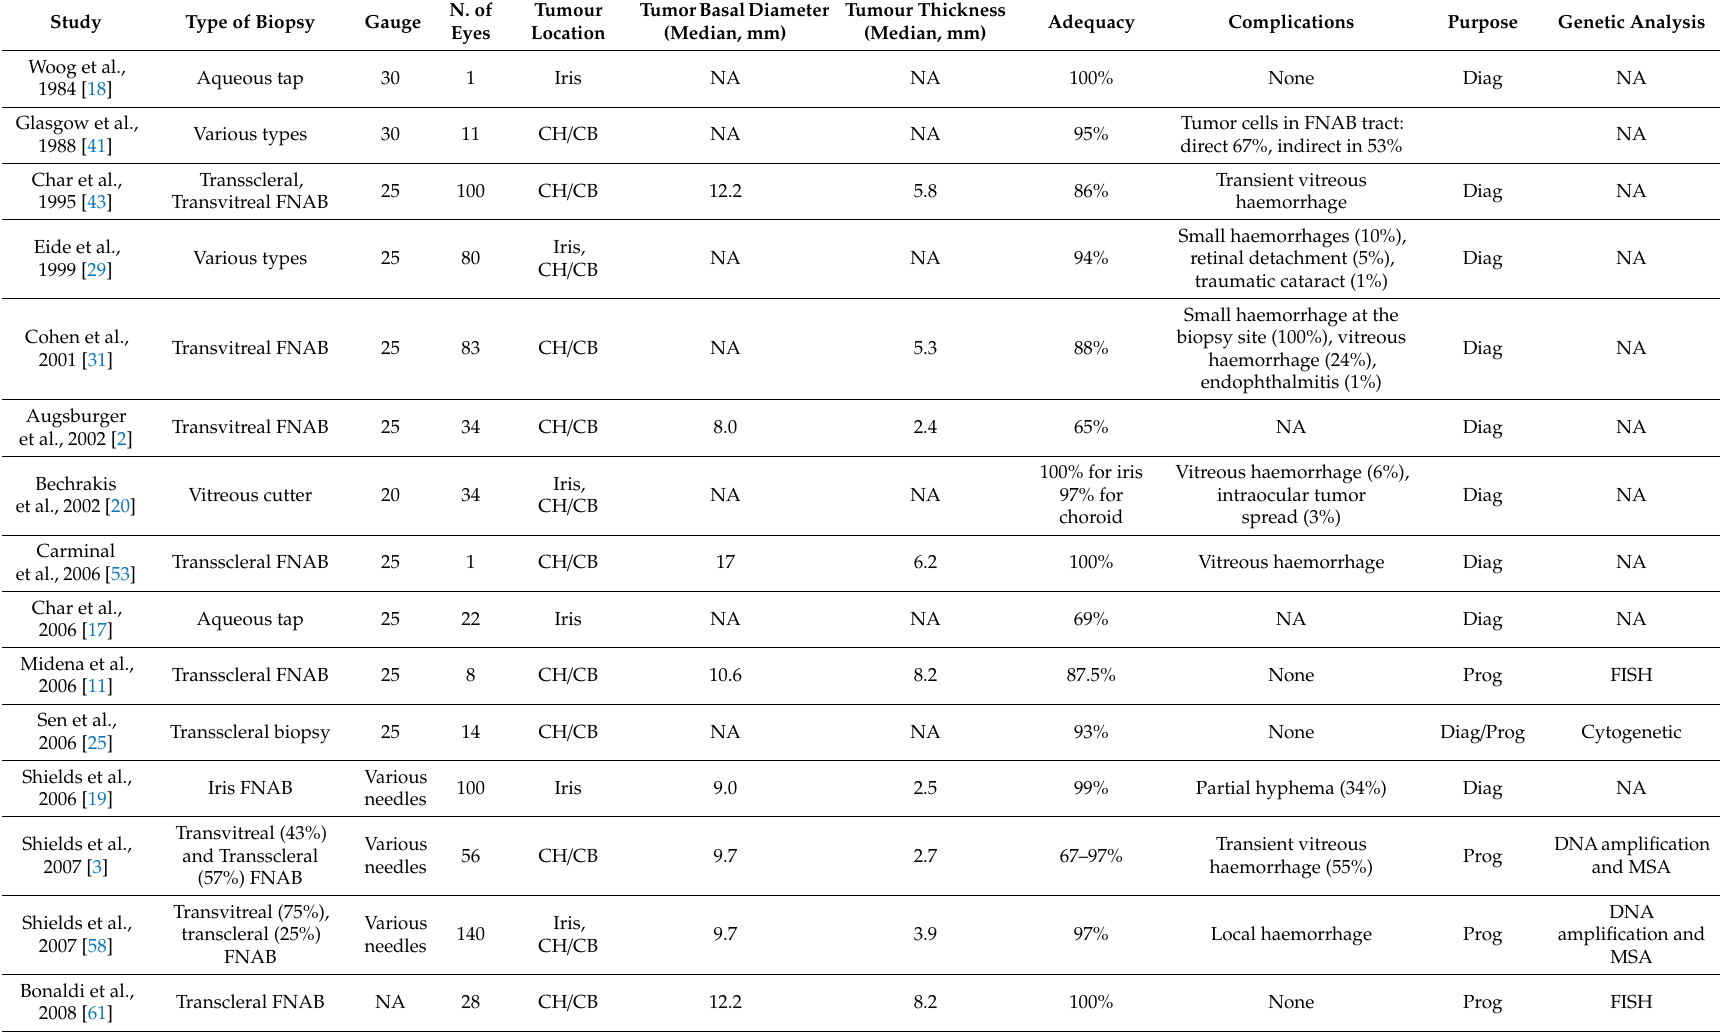
Table 2. Summary of main studies using biopsy for intraocular